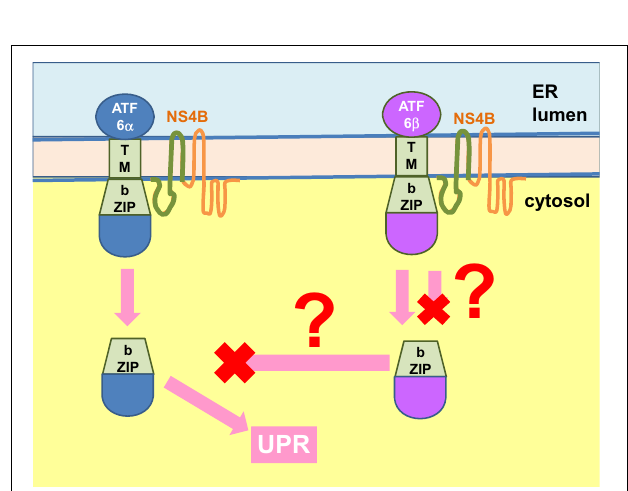
FK506-binding protein 8 (FKBP8) and the human butyrate-induced transcript 1 (hB-ind1). Disruption of co-chaperone-NS5A interaction (red serrated arrows) interrupts HSP90 chaperone activity, resulting in increased degradation of polyubiquitinated (Ub) proteins and perturbation of proteasomal function, leading to the unfolded protein response (UPR) (purple arrows).